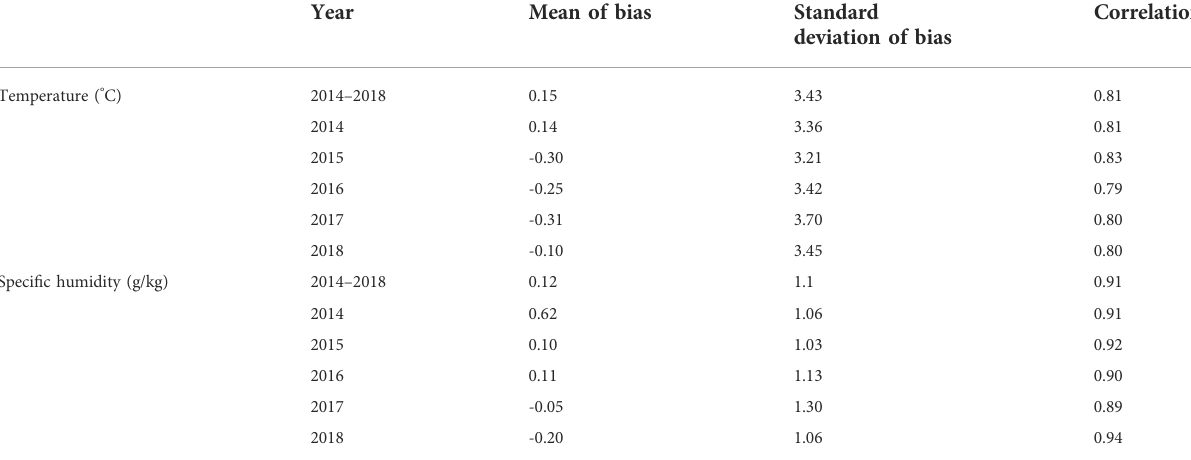
TABLE 2 Validation of AWS and ERA5 based on the region average of the Qingdao area from March to May 2014 – 2018. The data from AWS are at the surface and the data from ERA5 are at sea level pressure. Mean of